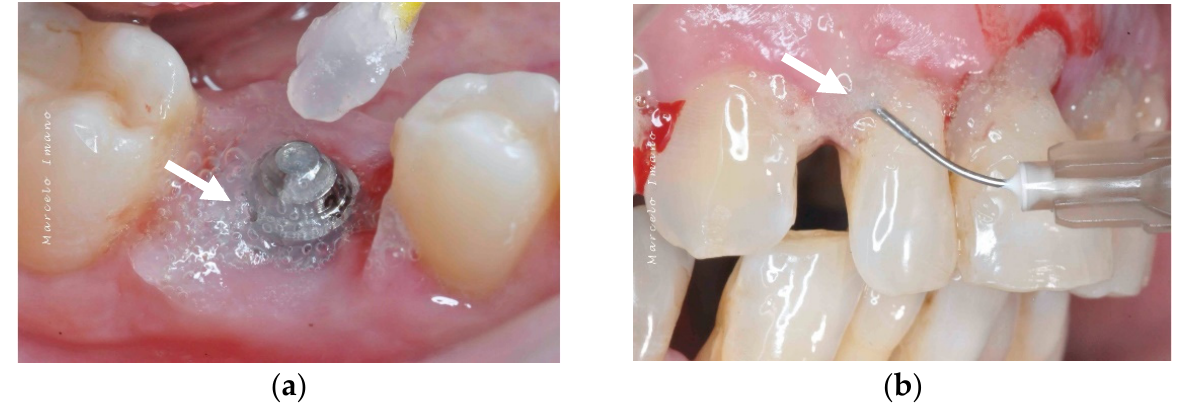
Figure 5. Application of blue ® m: ( a ) as a topical gel and ( b ) using a disposable syringe in the pockets (courtesy of Dr. Marcelo Imano). The white arrows are pointing to the blue ® m gel.